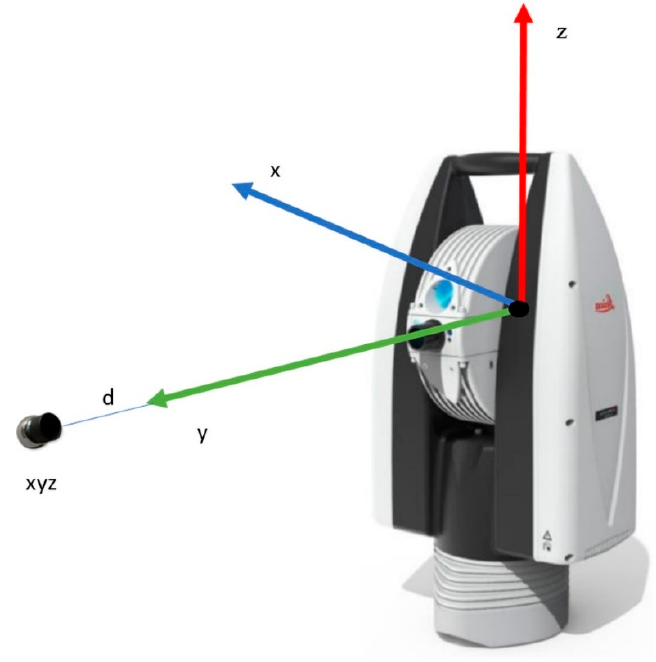
Figure 1. Measuring with a laser tracker.